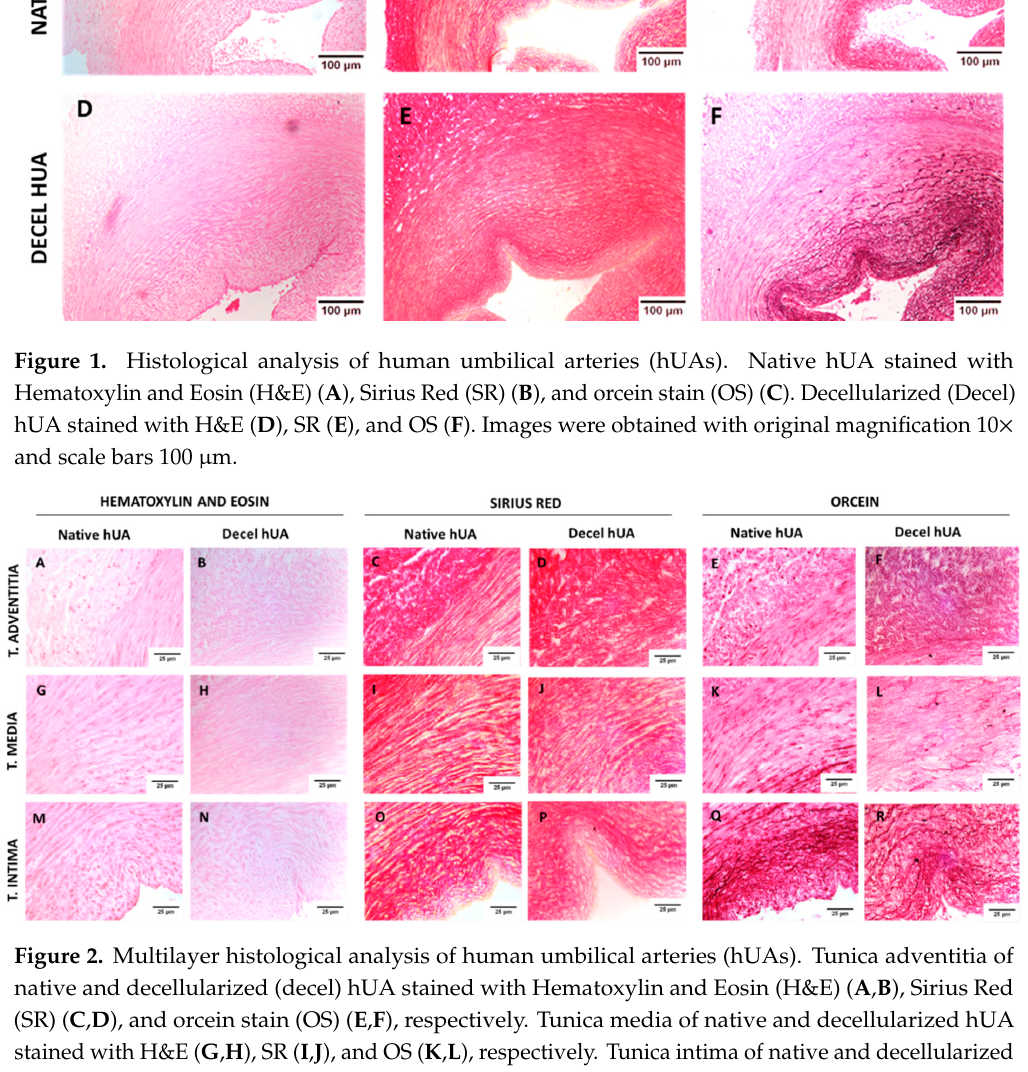
Figure 3. Indirect immunofluorescence and scanning electron microscopy (SEM) analysis in human umbilical arteries (hUAs). Indirect immunofluorescence against collagen type I ( A , D ) and fibronectin ( B , E ) in combination with DAPI staining in native and decellularized (decel) hUAs, respectively. Blue spots in images A and B represent the presence of cell nuclei. Images were obtained with original magnification 10x and scale bars 100 μ m. SEM analysis of native ( C ) and decellularized ( F ) hUAs. White arrows in image C, indicate the presence of cellular populations. White arrows in image F, indicate the preservation of ECM proteins, while no cellular populations are evident. Images were obtained with original magnification 40× and scale bars 25 μ m. 3.2. Biochemical Analysis and DNA Quantification Biochemical analysis of the hUAs involved the quantification of total hydroxyproline content (which corresponds to the collagen content) and sGAGs content. The hydroxyproline content was decreased in decellularized hUAs (110 ± 24 μ g hydroxyproline/mg dry tissue weight) compared to native hUAs (119 ± 27 μ g hydroxyproline/mg dry tissue weight), but this decrease was not statistically significant ( p < 0.05, Figure 4). On the other hand, a statistically significant difference was observed in the sGAGs content between native and decellularized vessels ( p < 0.01). Specifically, the sGAGs content before the decellularization was 6 ± 1 μ g sGAG/mg dry tissue weight, and after the decellularization was 2 ± 1 μ g sGAG/dry tissue weight (Figure 4). The DNA content appeared to significantly decrease in decellularized hUAs. The DNA amount of native and decellularized hUAs was 1577 ± 158 and 33 ± 5 ng DNA/mg dry tissue weight, respectively (Figure 4).